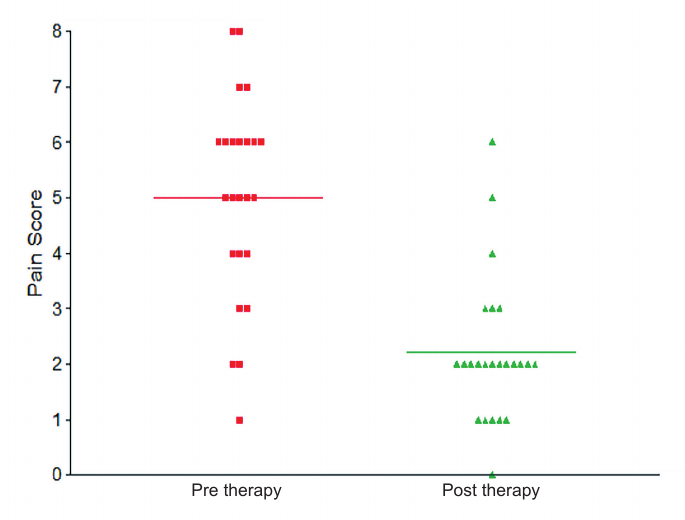
Figure 5 - Comparison of pain scores pre and post Zoledronic acid therapy in patients on ADT showing a significant improvement in pain